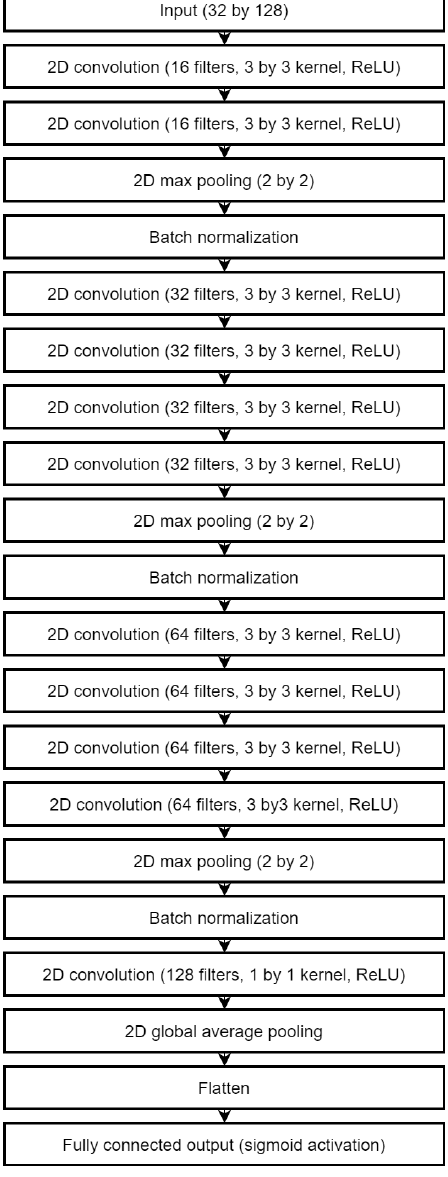
Figure 7. The architecture of the secondary classification